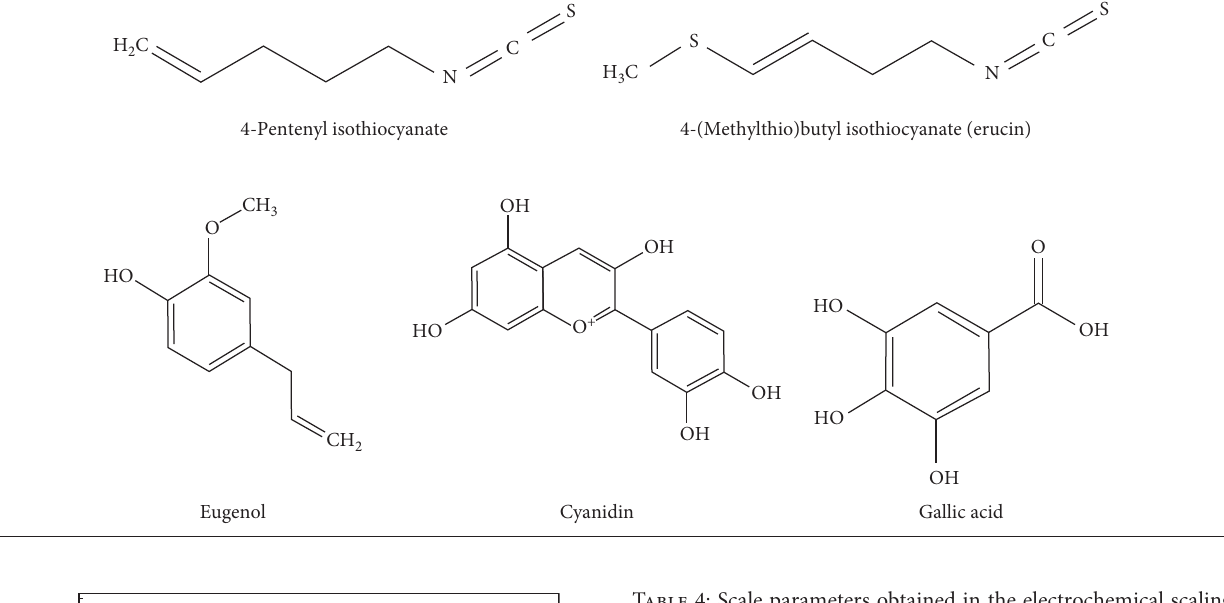
Table 3: Chemical structures of the main chemical constituents of the radish cake extract. H C 2